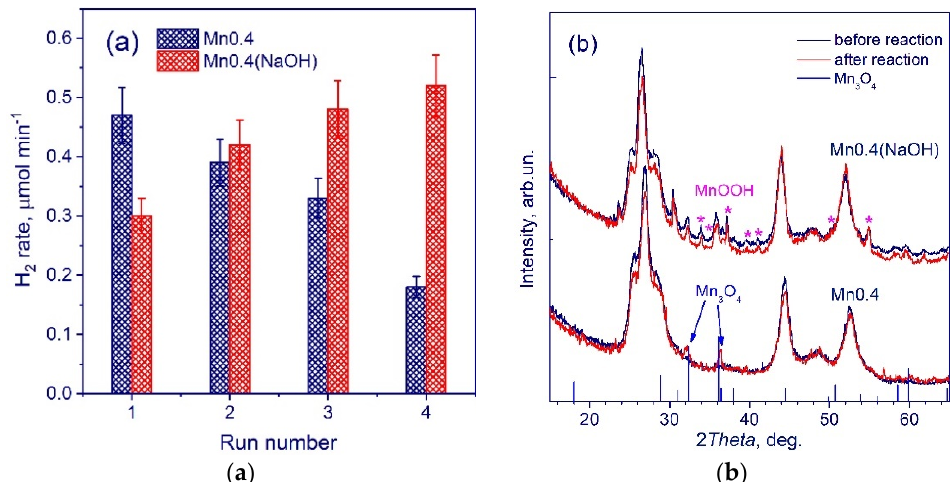
Figure 8. Consecutive photocatalytic runs over the samples Mn0.4(NaOH) and Mn0.4. Conditions: C 0 (Na 2 S/Na 2 SO 3 ) = 0.1 M, C cat = 0.50 g L − 1 , λ = 450 nm, 1 run lasted 1.5 h ( a ); XRD patterns of the samples Mn0.4(NaOH) and Mn0.4 before and after the hydrogen evolution ( b ). Table 3. The comparison of the activities of the synthesized samples with recently published data.